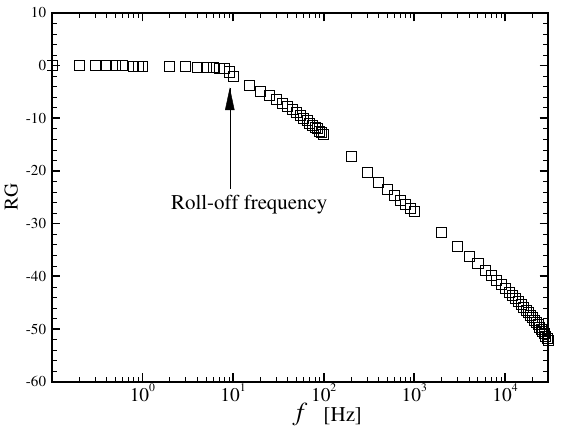
Fig. 9 Result of the frequency response